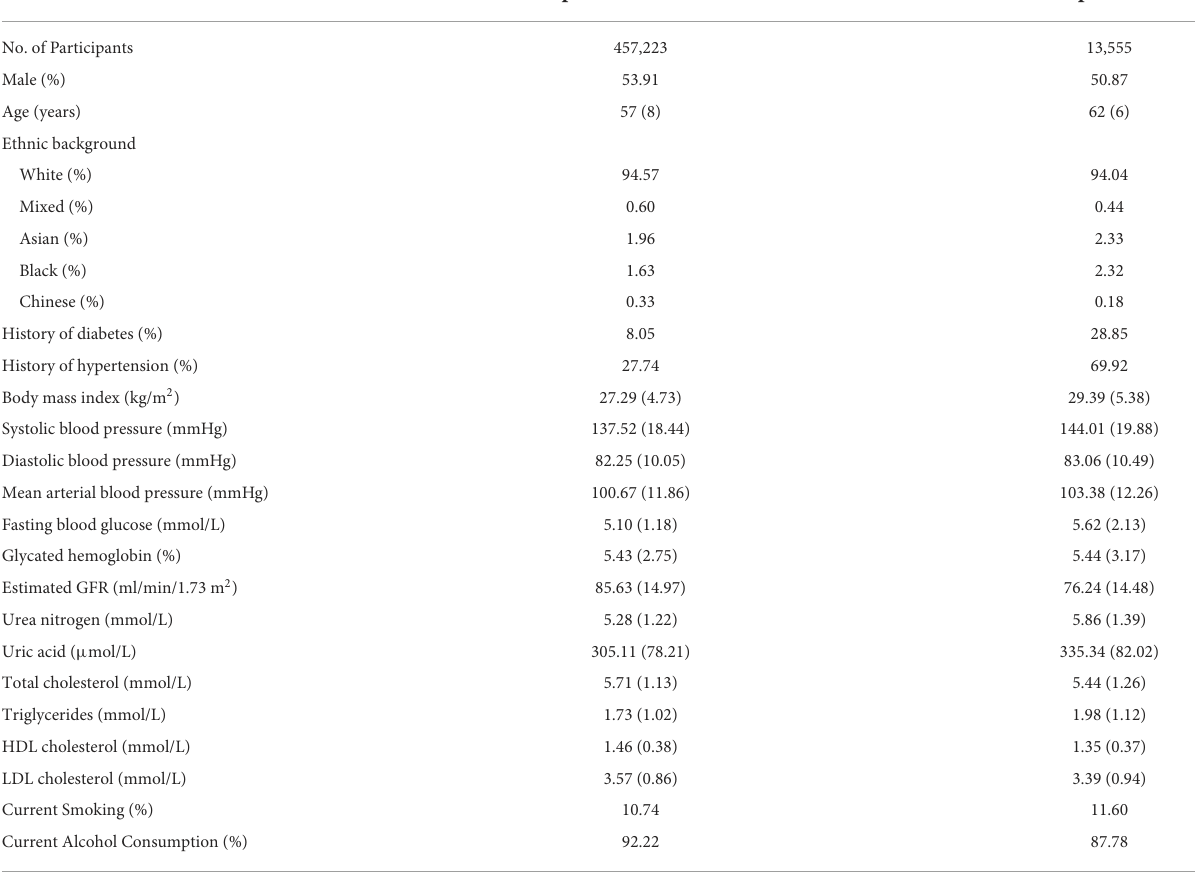
TABLE 1 Baseline characteristics of participants who kept free of CKD and during